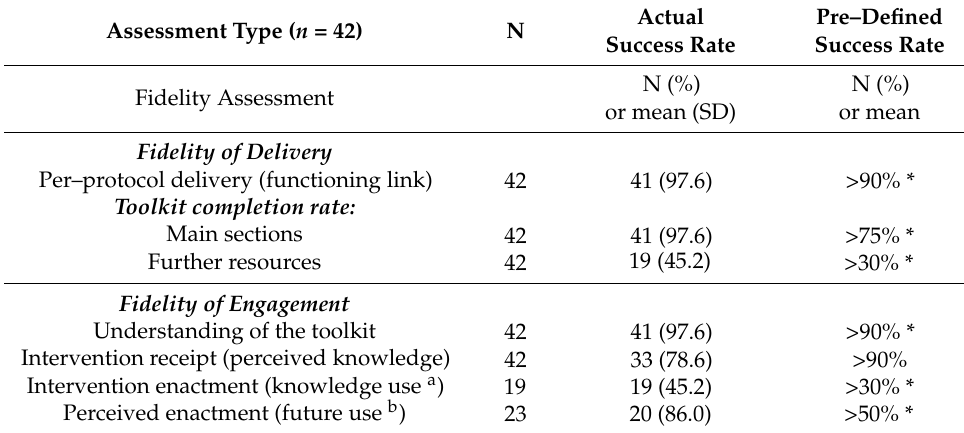
Table 3. Intervention fidelity and implementation